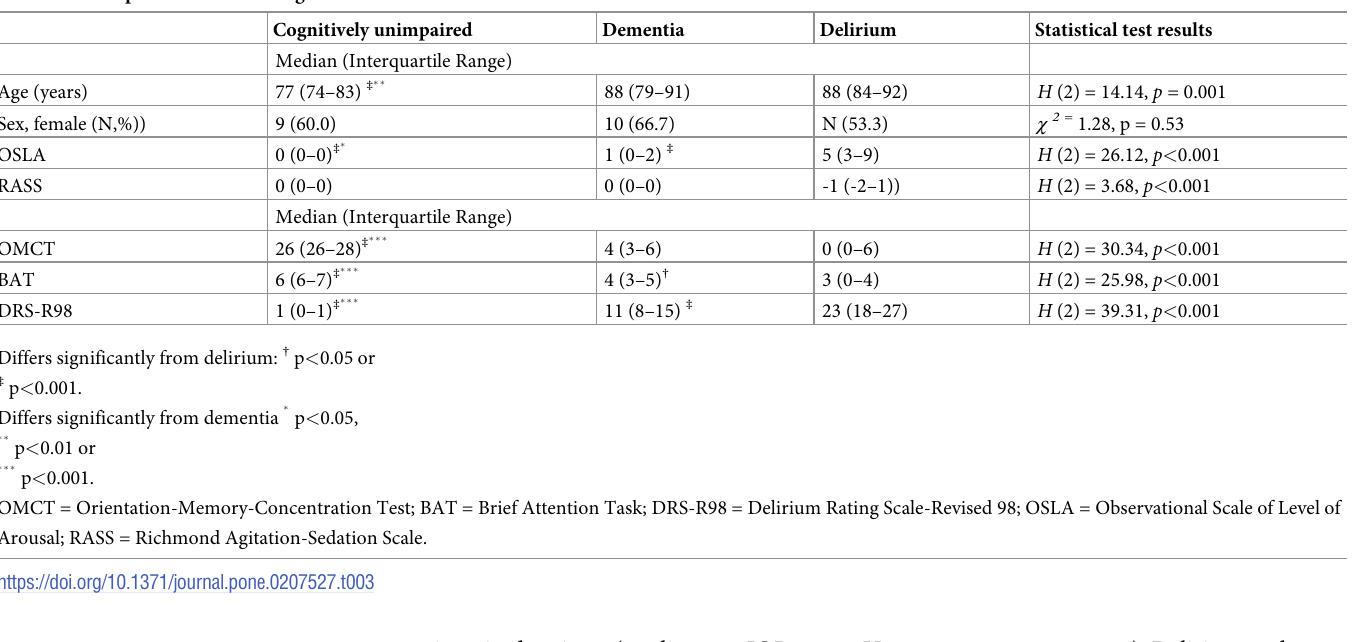
Table 3. Descriptive statistics for cognitive tests and behavioral scales.